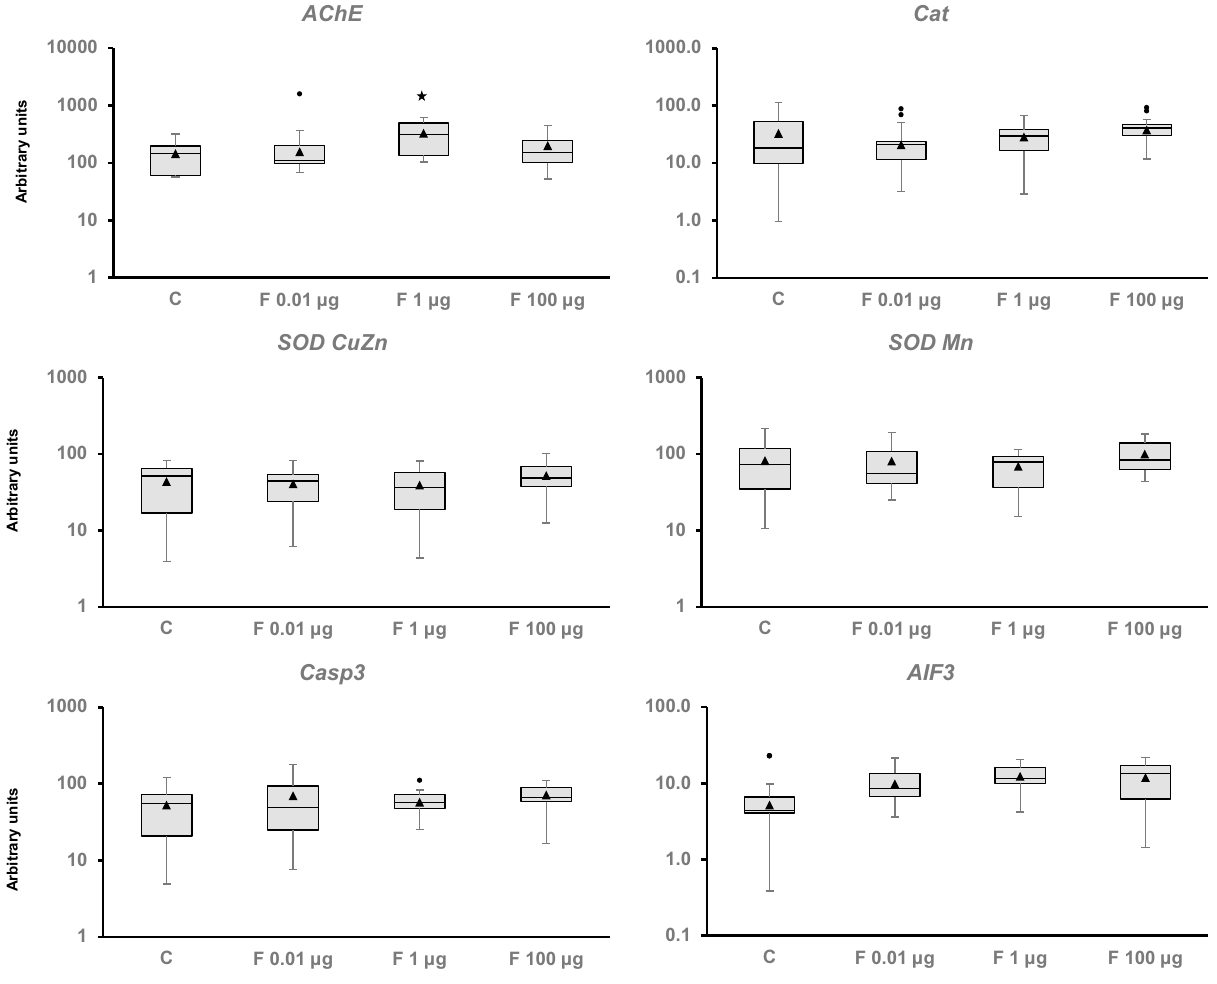
Figure 4. Transcriptional activity of genes related to the nervous system ( acetylcholinesterase [ AChE ]), oxidative stress ( catalase [ Cat ], copper-zinc superoxide dismutase [ SOD CuZn ], and manganese superoxide dismutase [ SOD Mn ]), and apoptosis ( caspase 3 [ Casp3 ] and apoptosis inducing factor 3 [ AIF3 ]). Snails were exposed to Fenoxycarb for seven days at 19 °C. Quantification by RT-PCR was performed using ribosomal protein L10 ( rpL10 ), actin ( Act ), 6-phosphofructo-2-kinase/fructose-2,6-biphosphatase 2 ( PFKFB2 ), and glyceraldehyde-3- phosphate dehydrogenase ( GAPDH ) as reference genes. The comparison was performed with the solvent-exposed controls. Whisker boxes are shown. Each box corresponds to 12 individuals. The median is indicated by the horizontal line within the box, and the 25th and 75th percentiles are indicated by the boundaries of the box. The highest and lowest results are represented by the whiskers. The small triangle inside the box denotes the mean, and the outliers are shown (circles). Significant difference relative to the control (asterisk) is indicated (p <